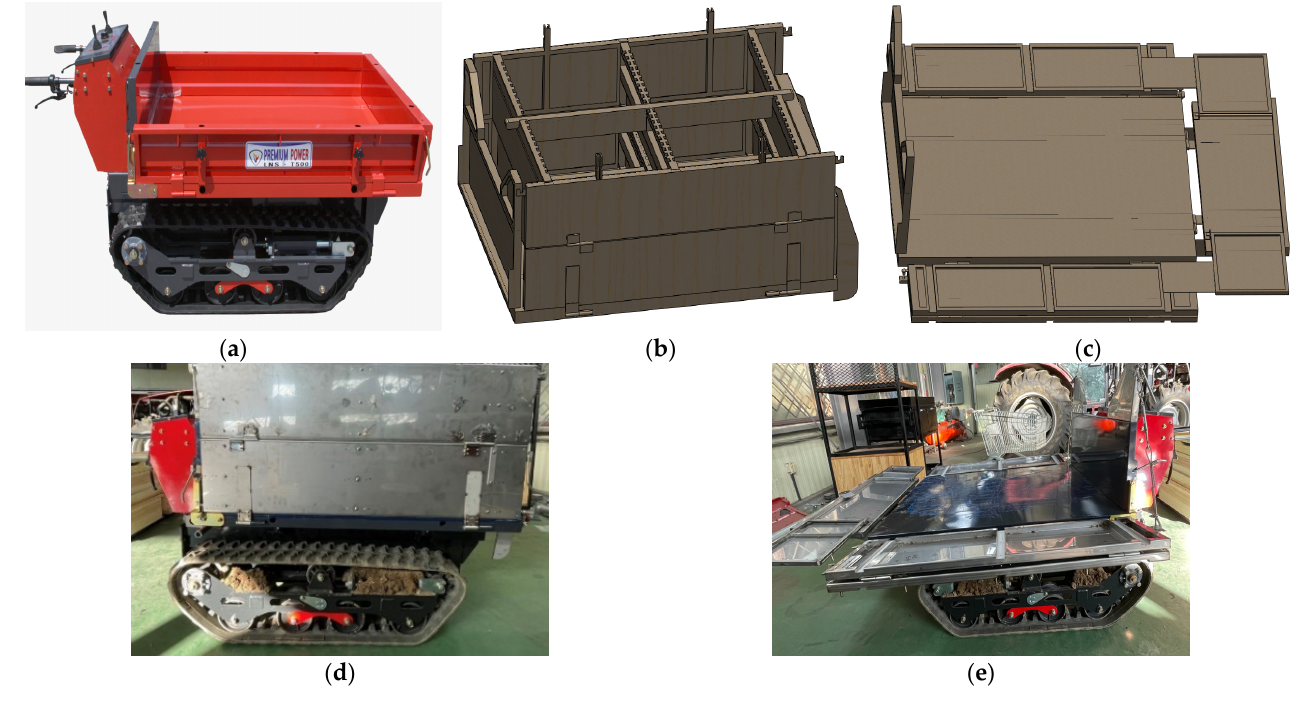
Figure 1. ( a ) LNS T500 tracked vehicle; ( b ) design model of the loading box when folded; ( c ) design model of the loading box when unfolded; ( d ) actual vehicle loaded with bee frames; ( e ) actual vehicle loaded with beehives.